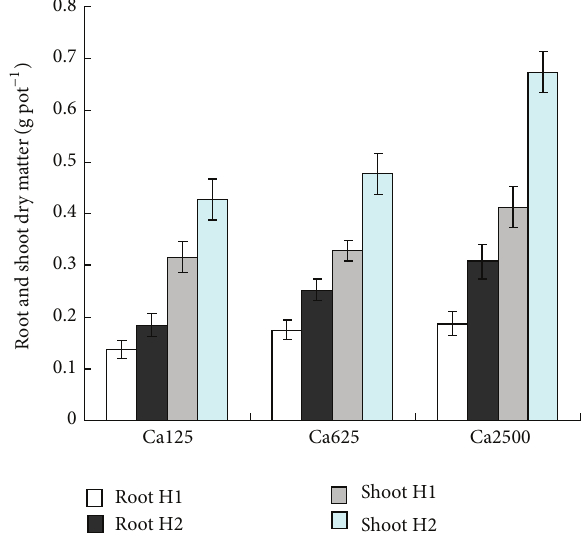
Figure 1: Effects of different levels of Ca supply on root and shoot dry matter of wheat seedlings without Al at H1 and with Al at H2. After 14d of Ca treatment, the seedlings were exposed to 100 𝜇 M Al for additional 6 d for H2. Values are the means ± SE of three replicates.